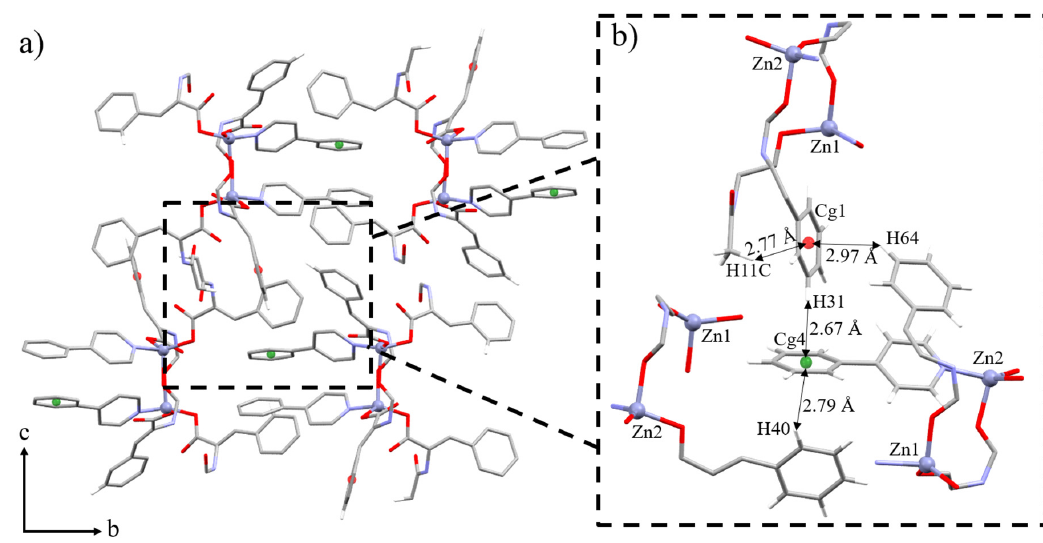
Figure 3. ( a ) General view of the supramolecular bc plane. ( b ) In-detail view of the former C-H ··· π interactions in 1 . The phenyl, pyridyl and other atoms which do not participate in any of the mentioned interactions have been omitted for clarity.